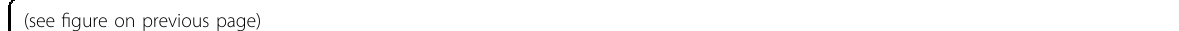
Fig. 6 Indirect modulation of G-CSF on T and NK cells. a Sankey plot showing the upregulated intercellular communication between the potential sender cells and effector CD8 + T cells upon G-CSF administration. Differential intercellular communication analysis was performed using R package scDiffCom. Ligand – receptor pairs with adjusted P value < 0.05 and fold change > 1.5 are displayed. b Plot showing regulation of top predicted target genes in effector CD8 + T cells mediated by upregulated ligand – receptor pairs between effector CD8 + T cells and potential sender cells. Transcription factors in target genes are represented as diamonds. The ligand – receptor – target relationship was obtained from the database containing ligand – receptor interactions and receptor – transcription factor interactions in R package scMLnet, and database including ligand – receptor interactions and ligand – target links in R package NicheNet. c Heatmap showing the average expression of the downstream target genes in b in effector CD8 + T cells before and after G-CSF administration. d Sankey plot showing the upregulated intercellular communication between the potential sender cells and NK cells upon G-CSF administration. e Plot showing the regulation of top predicted target genes in NK cells mediated by upregulated ligand – receptor pairs between NK cells and potential sender cells. f Heatmap showing the average expression of the target genes in e in NK cells before and after G-CSF